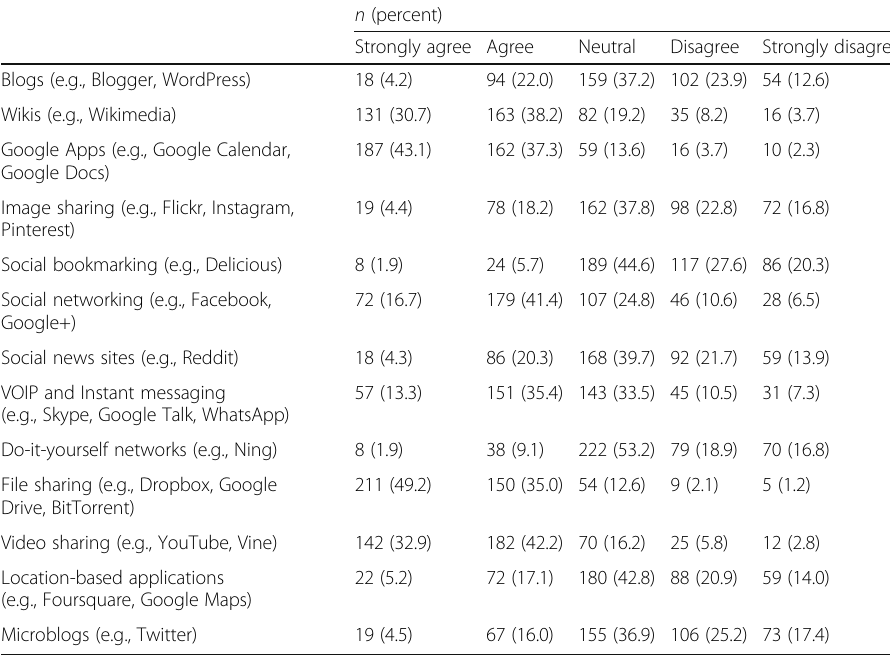
Table 3 Q14: In your opinion, do you see these social media as an important part of your university learning?